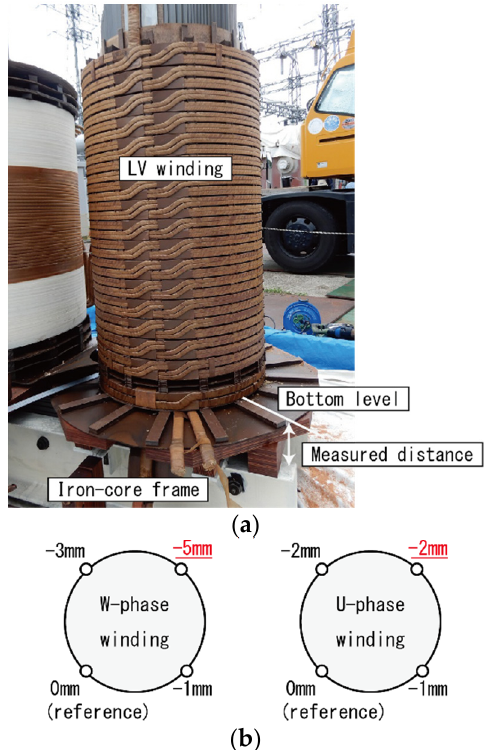
Figure 11. Result of the investigation by dismantlement: ( a ) Photo of LV winding and ( b ) measured distance from the iron-core frame to the bottom of LV winding (bottom view) [35].